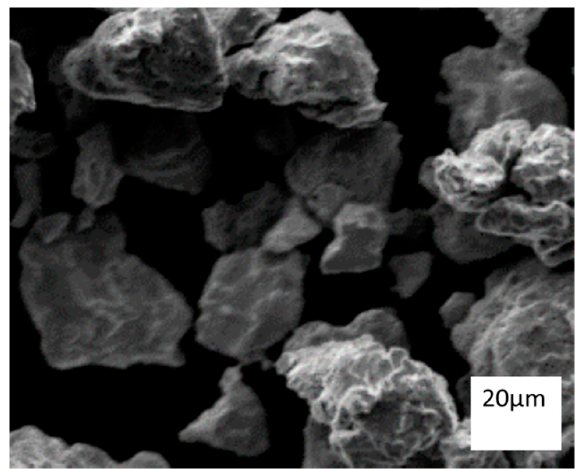
Figure 10. Photomicrography of stainless steel powder of milling parameters of 350 rpm, mass/ball ratio of 1/20, milling time of 50 h.